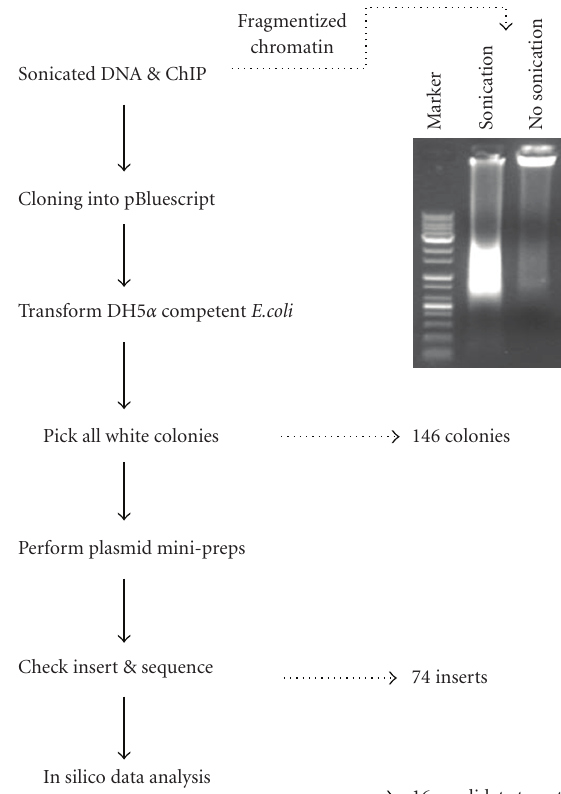
Figure 1: ChIP-cloning flow chart. The procedure of ChIP methods is based on Upstate manufacture’s instructions. The embryos (E11.5) and F9 cells were prepared for ChIP-cloning as detailed